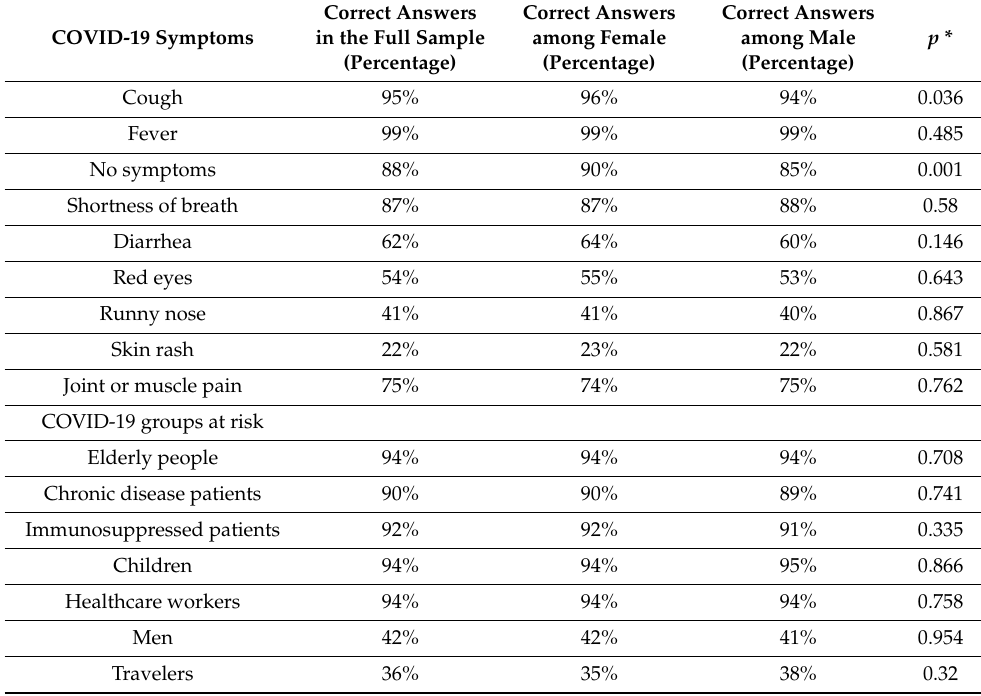
Table 3. Percentage of correct answers regarding COVID-19 symptoms and categories of people at high risk of infection in the full sample and in the groups of female and male